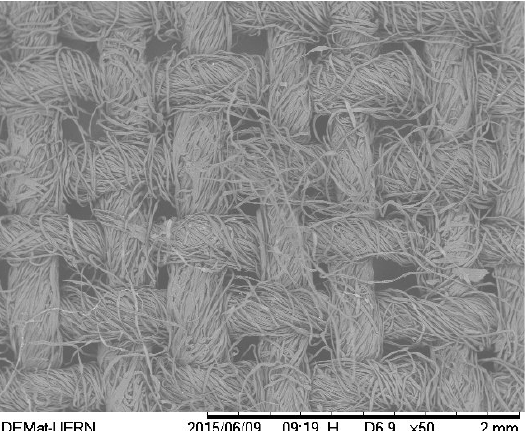
Figure 1. Image of the fabric used with 50x